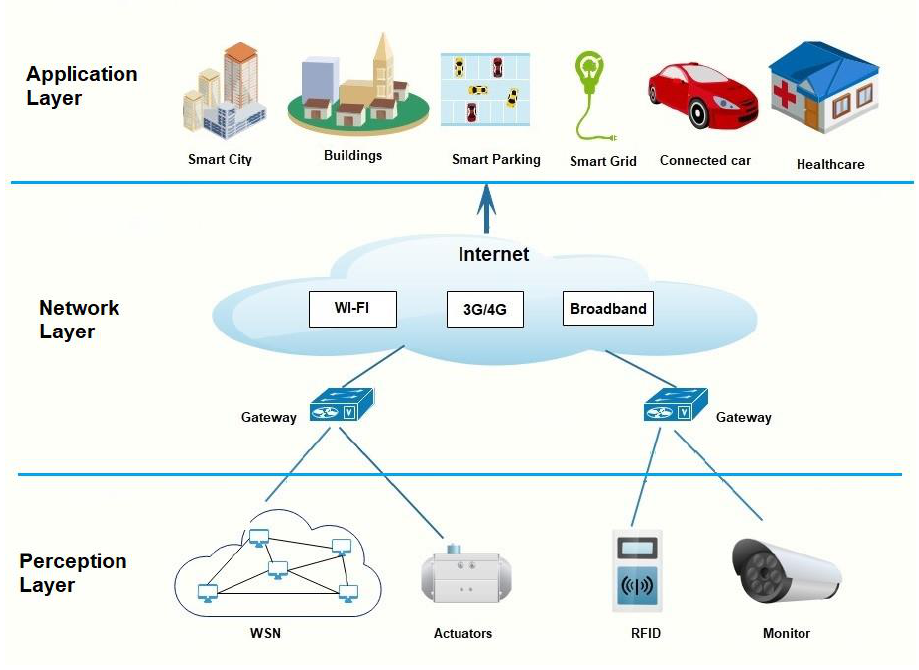
Figure 3. Three-layer architecture of the IoT system.